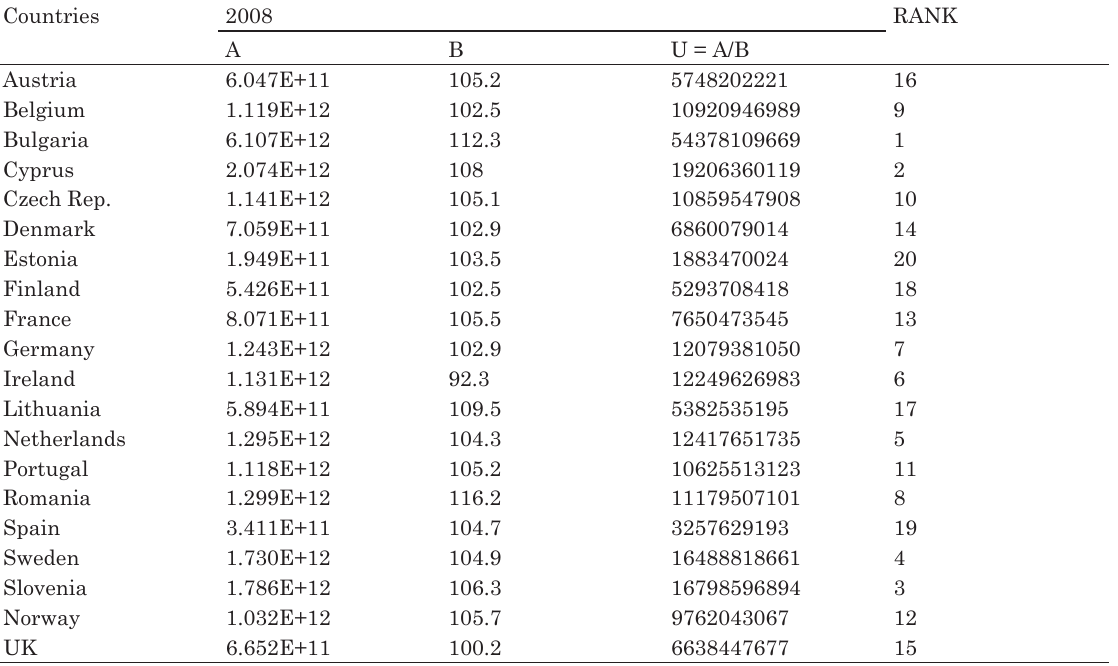
Table A2a. The full multiplicative form and ranks of states, 2008 Countries